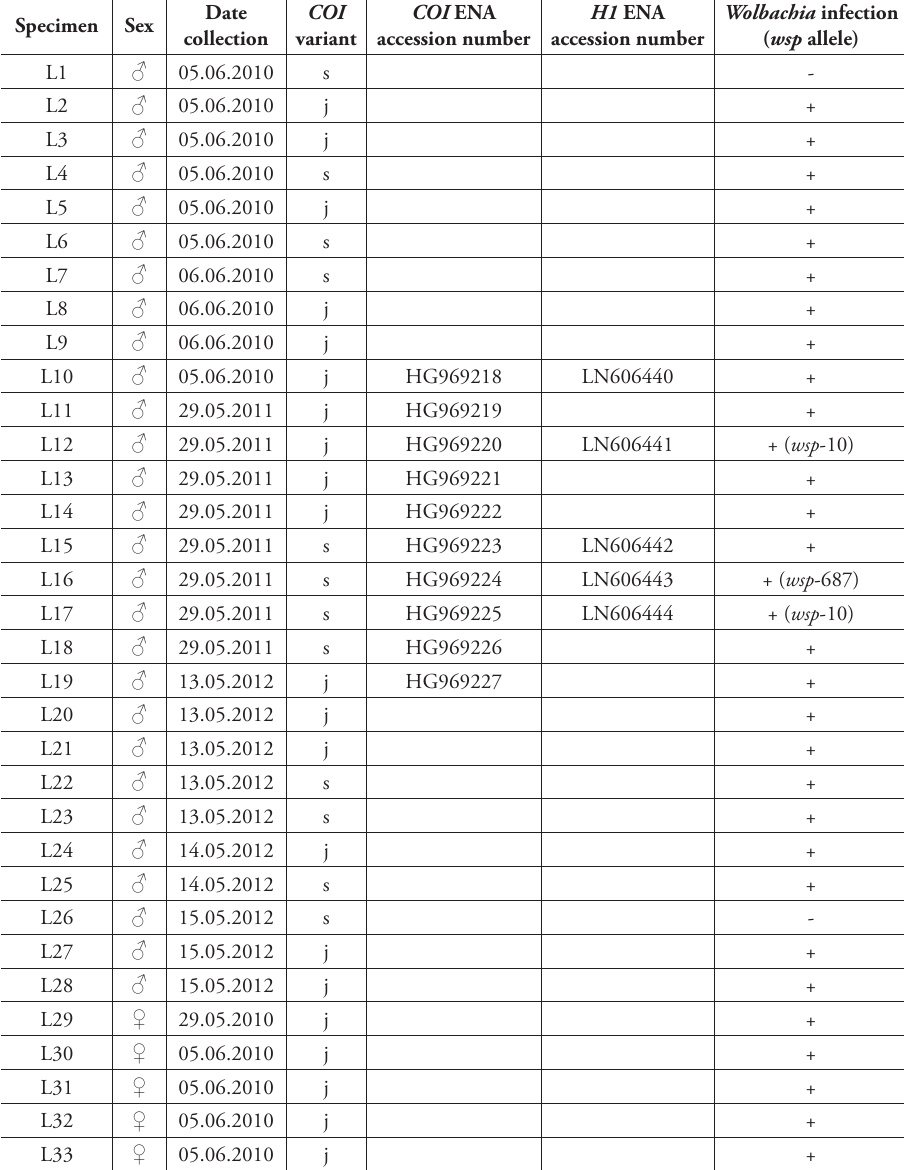
Table 1. Material collected, COI gene allelic states as revealed by CAPS approach (denoted as follows: s – Leptidea sinapis , j – L. juvernica , a – L. amurensis , m – L. morsei ), European Nucleotide Archive (ENA) accession numbers of the COI and H1 gene sequences, presence of Wolbachia infection (+ detected; - not detected) and the wsp alleles according to the PubMLST